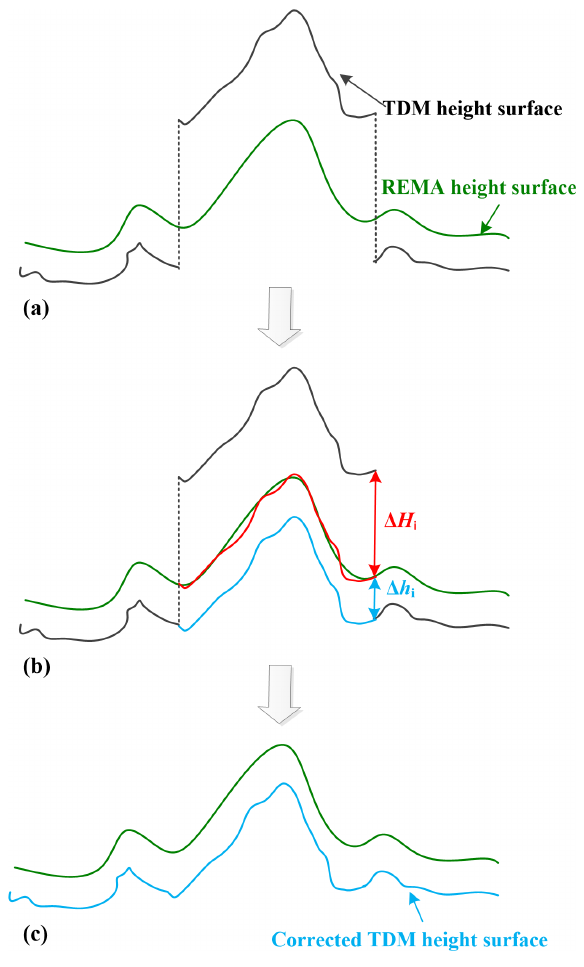
Figure 5. Schematic representation of the local elevation offset cor- rection procedure. (a) Erroneous elevation jump of the TDM DEM and the REMA surface elevation, (b) Correction of the jump with fitted elevation surface as in Eq. (3). Red: corrected elevation sur- face with mean offset. Blue: corrected elevation surface with addi- tional fitted elevation surface. (c) Finally corrected TDM DEM.